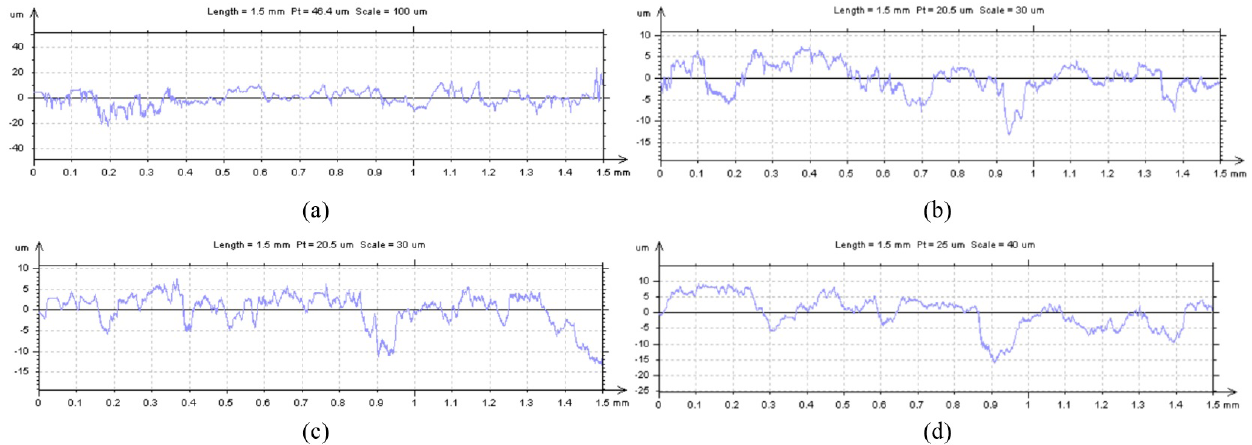
Figure 6. Result of the surface roughness using the DIAVITE DH-6. (a) Raw data of surface-treated specimen using grit 40 grinder blades. (b) Raw data of surface-treated specimen using grit 80 grinder blades. (c) Raw data of surface-treated specimen using grit 150 grinder blades. (d) Raw data of virgin specimen.